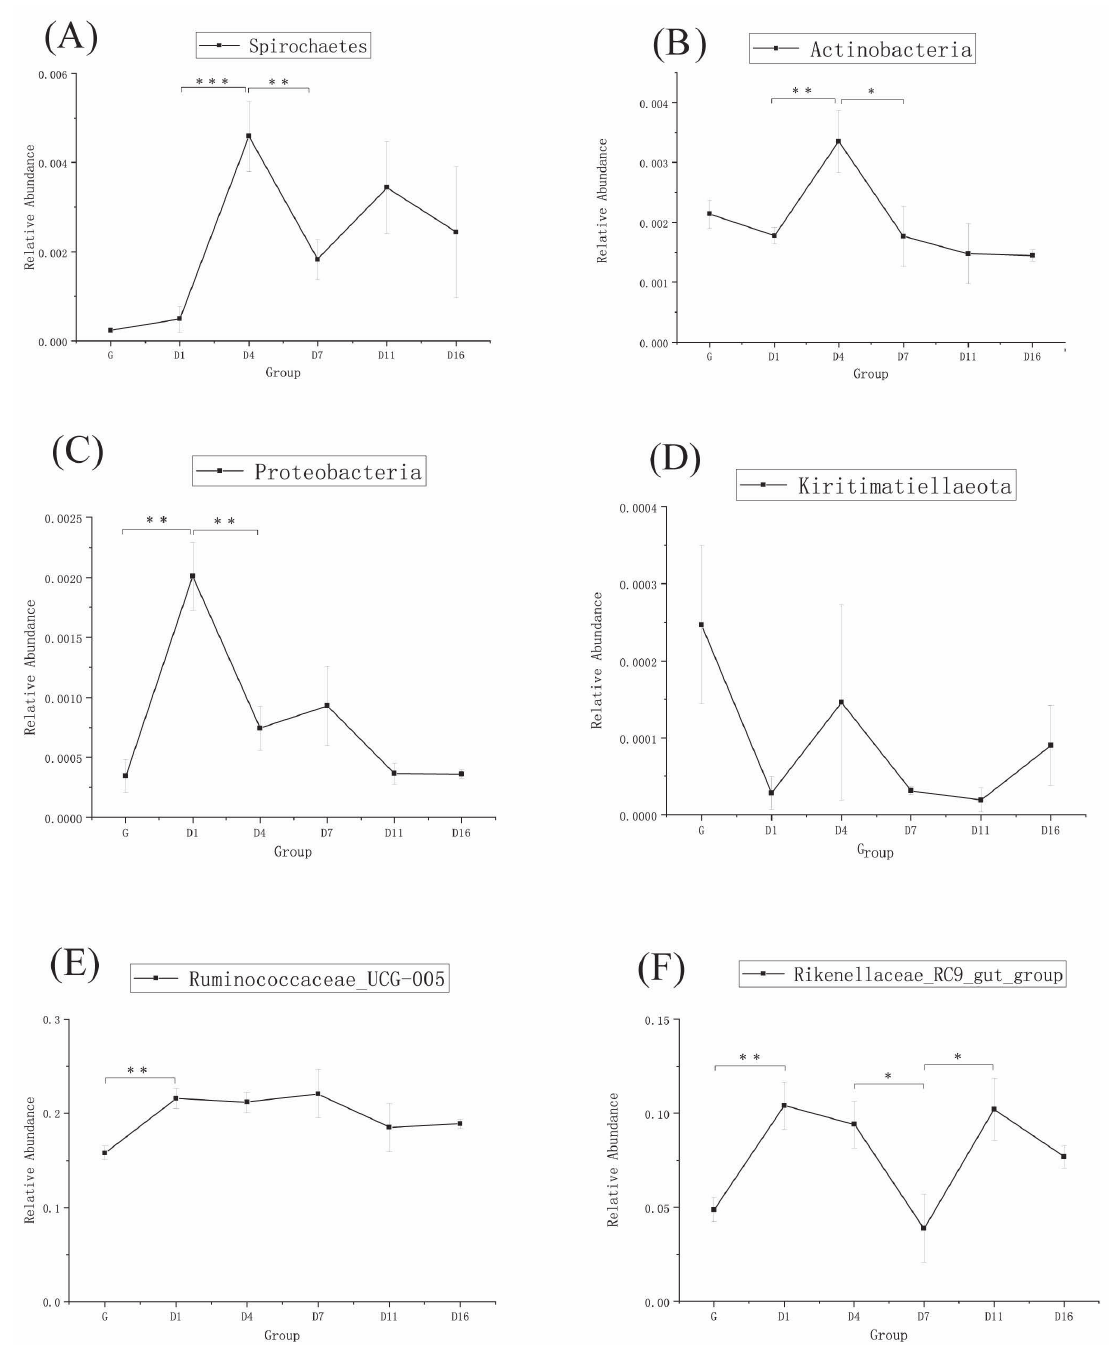
Figure 5. MetaStats analysis of top phylum and genus bacterial of yak: ( A – D ) phylum and ( E , F ) genera, and * means p -value < 0.05, ** means p -value < 0.01, *** means p -value < 0.001. (G: grazing; D1, D4, D7, D11, and D16: feedlot feeding days 1, 4, 7, 11, and 16,